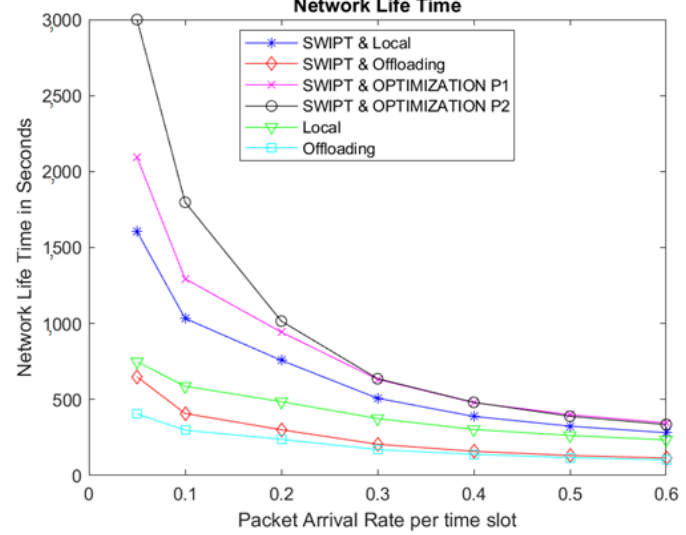
Figure 16. Network lifetime for the variable packet arrival